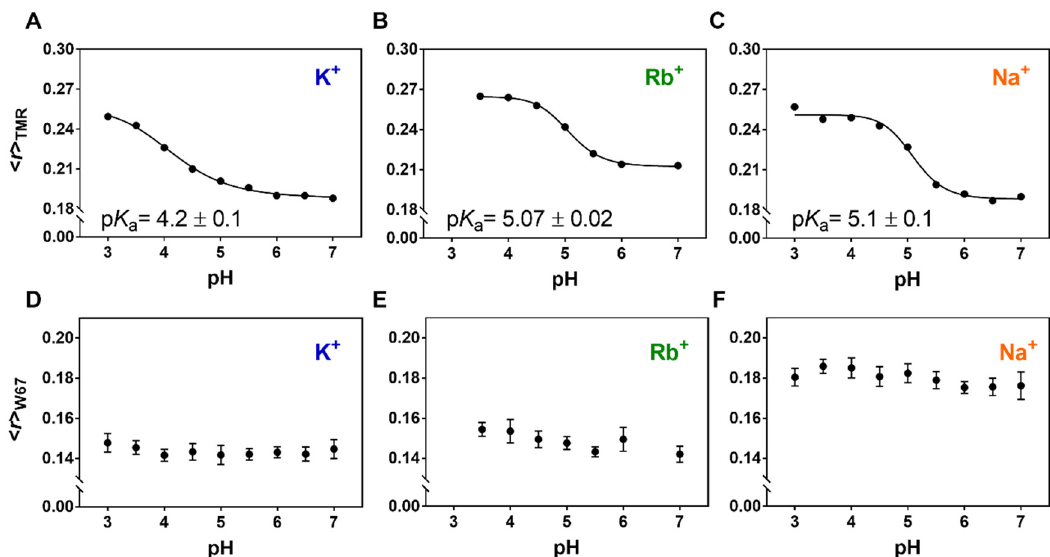
Figure 6. Influence of SF ion occupancy on the activation p K a of KcsA. Variation with pH of the steady-state fluorescence anisotropy of the conjugated TMR, < r > TMR ( A – C ), and W67, < r > W67 ( D – F ) in TMR-labeled G116C W67 KcsA. The experi- ments were conducted in the presence of 200 mM ( A , D ) KCl (D:P 0.45), ( B , E ) RbCl (D:P 0.38), and ( C , F ) NaCl (D:P 0.45). The measuring conditions were < r > TMR : λ ex = 490 nm λ em = 580 nm and < r > W67 : λ ex = 300 nm λ em = 340 nm. The empirical fits of a Hill equation to the sigmoidal behavior of < r > TMR vs. pH data (solid lines) show a ( A ) p K a (K + ) = 4.2 ± 0.1, ( B ) p K a (Rb + ) = 5.07 ± 0.02 and ( C ) p K a (Na + ) = 5.10 ± 0.07, respectively. The buffers also contained 5 mM DDM (T = 25 °C).